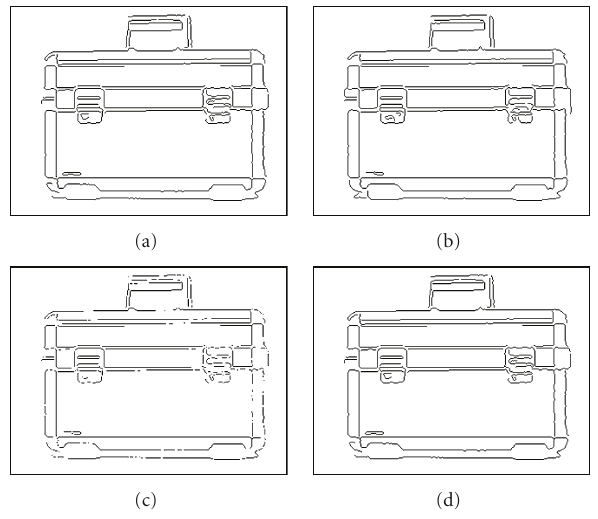
Figure 4: Advantages of segment-based matching. (a) Edge image of an object; (b) edge image of the same object at di ff erent time; (c) result obtained through pixel-based matching; (d) result obtained through segment-based